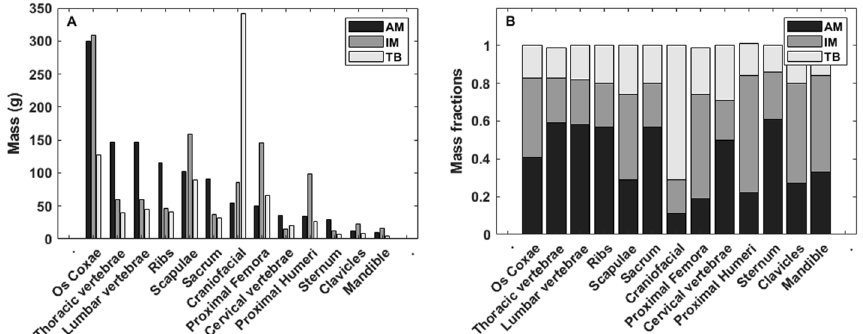
Fig. 3 Active marrow, inactive marrow, and trabecular bone masses of the University of Florida Adult Male Hybrid Phantom for 13 skeletal sites A and the corresponding mass fractions of each skeletal site B